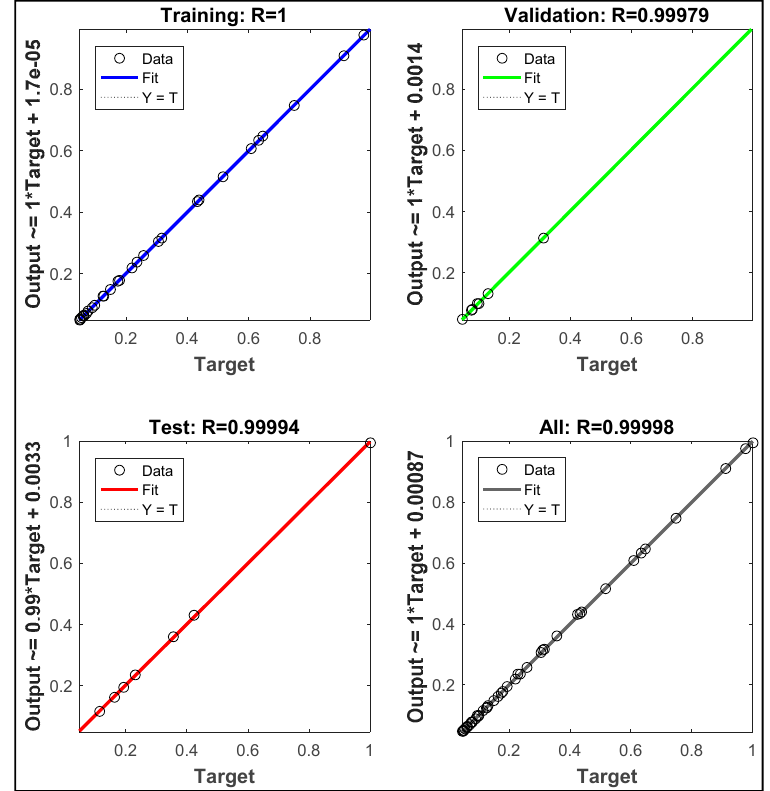
Figure 11. Artificial neural network (ANN) regression plots for sample Y. Energies 2019 , 12 , x FOR PEER REVIEW